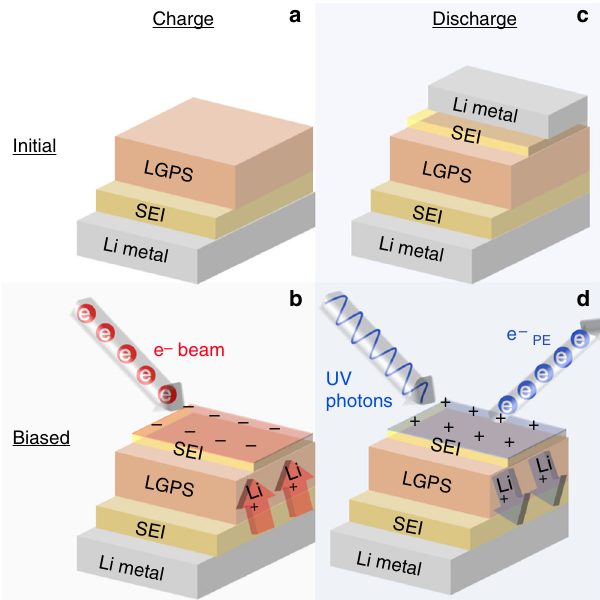
Fig. 8 Schematic of opXPS virtual electrode method. Schematic showing a the initial structure of the LPS/Li foil , b the structure part of the way through the charge step, c the structure after the charge cycle is complete before right discharge and d the Li/LPS/Li foil during the discharge